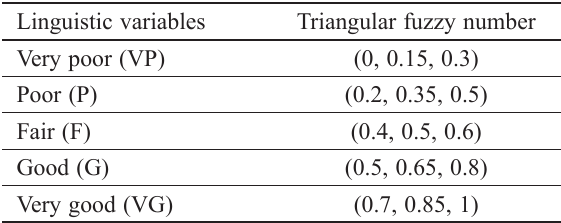
Table 1. Linguistic variables for the rating of alternatives Linguistic